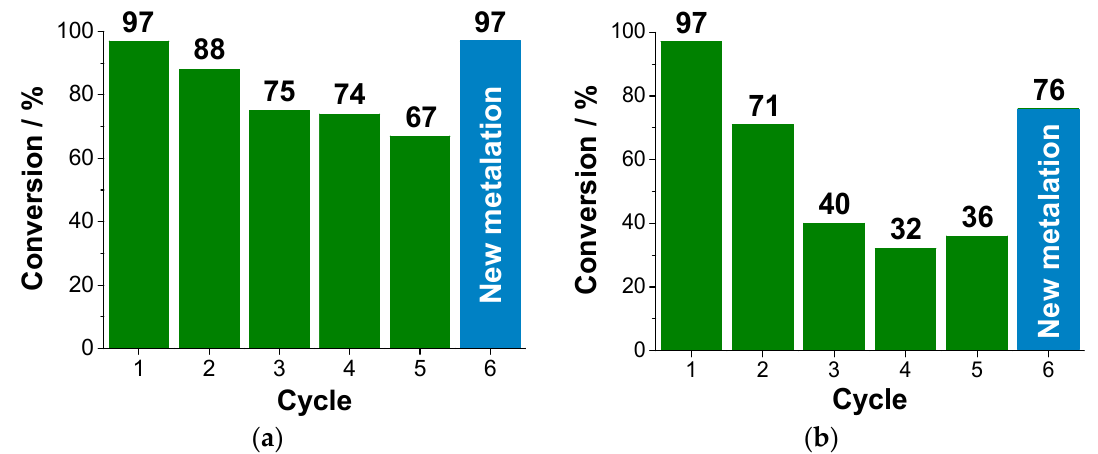
Figure 12. Effect of catalyst reuse cycles on conversion efficiency: ( a ) Cu@T-POP1 and ( b ) Cu@T-POP2.